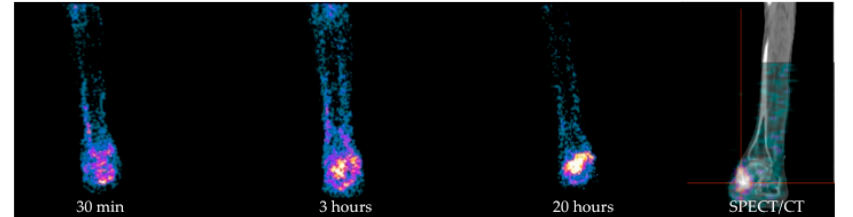
Figure 4. Example of 99m Tc-HMPAO WBC scintigraphy in a patient with a skin ulcer in the medial right malleolus region, previous amputations of left leg, and of all metatarsal heads of the right foot. From left to right: Planar images acquired after 30 min, 3 h, and 20 h p.i. of radiolabelled autologous leukocytes show an increased amount of activity over time in terms of intensity and extent, being consistent with OM with an involvement of adjacent soft tissues. Further SPECT/CT acquisition (right panel) correctly localized the uptake in the right talus and accurately evaluated its extent into surrounding soft tissues. HMPAO: hexamethylpropylene amine oxine, WBC: white blood cell.